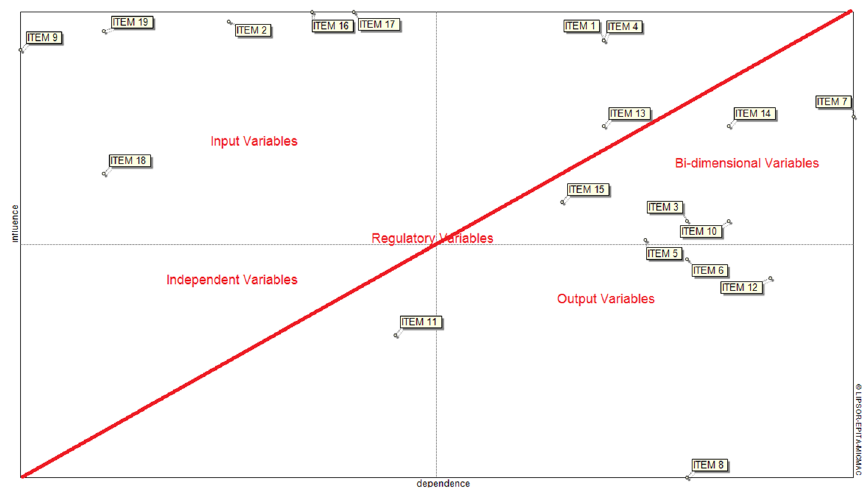
Fig. 1 Map of variables with direct influence/dependence